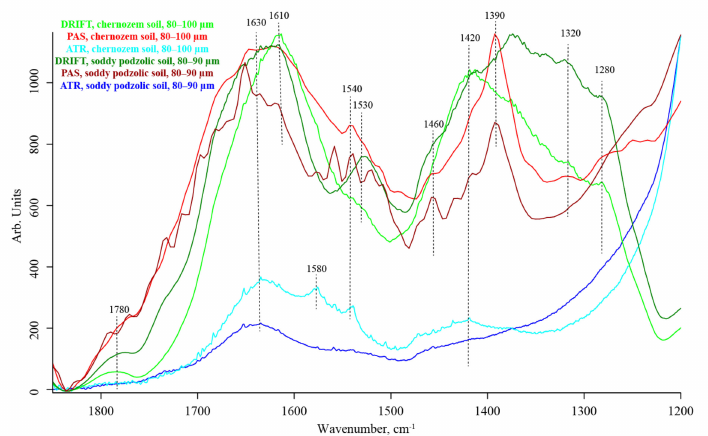
Figure 8. Normalized FTIR spectra in the region 1850–1200 cm − 1 . DRIFT, ATR, and PAS (IMF, 1.6 kHz) spectra of shelterbelt chernozem soil (dry fractionation, 80–100 µ m), light green, light blue, and light red, respectively; and DRIFT, ATR, and PAS (IMF, 1.6 kHz) spectra of sod-podzolic soil (dry fractionation, 80–90 µ m), dark green, dark blue, and dark red,